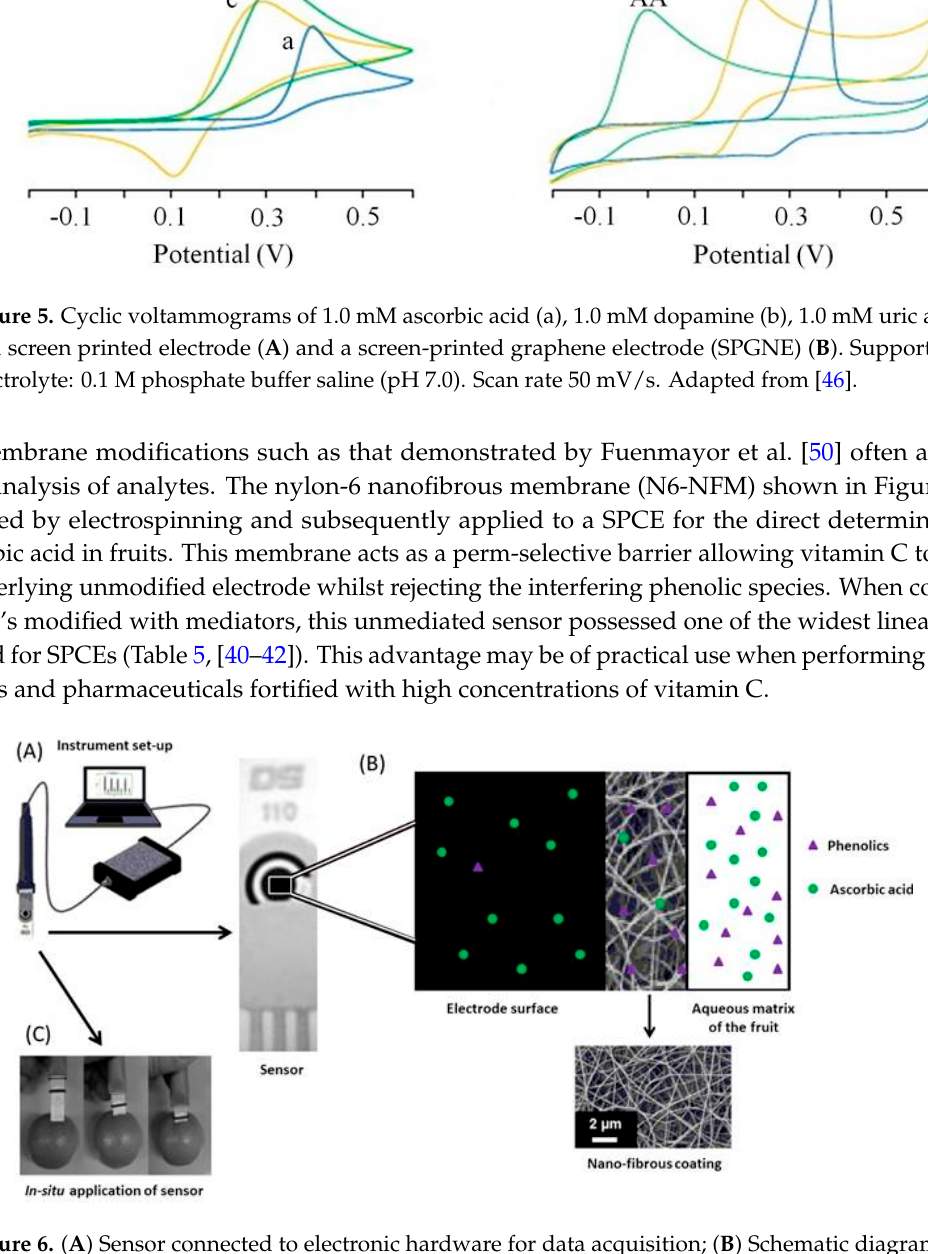
Figure 6. ( A ) Sensor connected to electronic hardware for data acquisition; ( B ) Schematic diagram of membrane role, with SEM image of nylon-6 coating; ( C ) Photograph demonstrating the in-situ analysis of ascorbic acid in fruit. Adapted from [50].